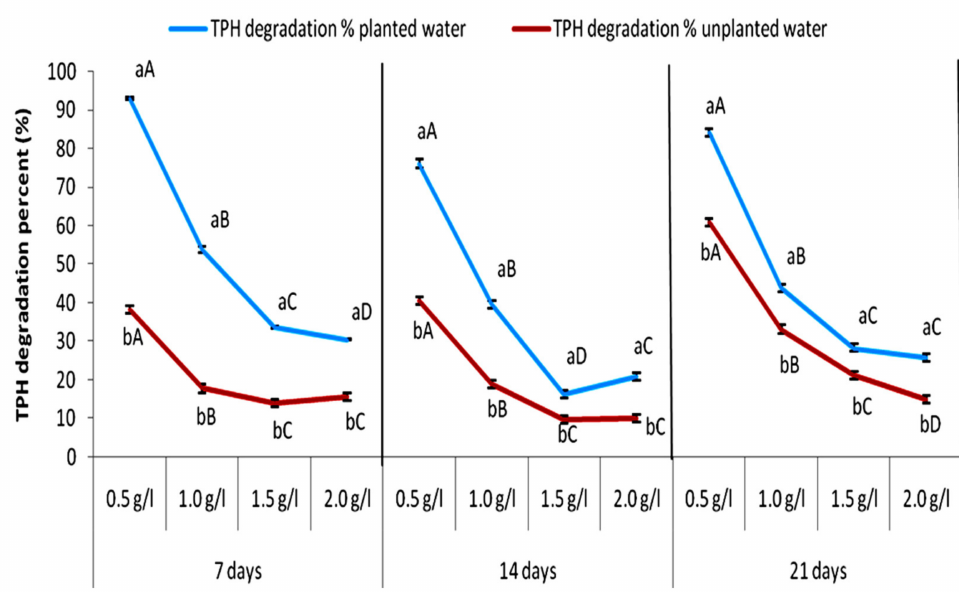
Figure 1. Time-dependent degradation percentages (%) of total petroleum hydrocarbons (TPHs) in freshwater treated with different concentrations of crude oil and planted with the Azollapin- nata / Anabenaazollaea (A-A) combination for seven days, fourteen days and twenty-one days com- pared with unplanted water. Values are expressed as the mean ± SE. Different lowercase letters indicate significant differences between the planted and unplanted treatments at each oil concentra- tion, and different capital letters indicate significant differences at each oil pollution level at p ≤ 0.05 according to Duncan’s multiple range